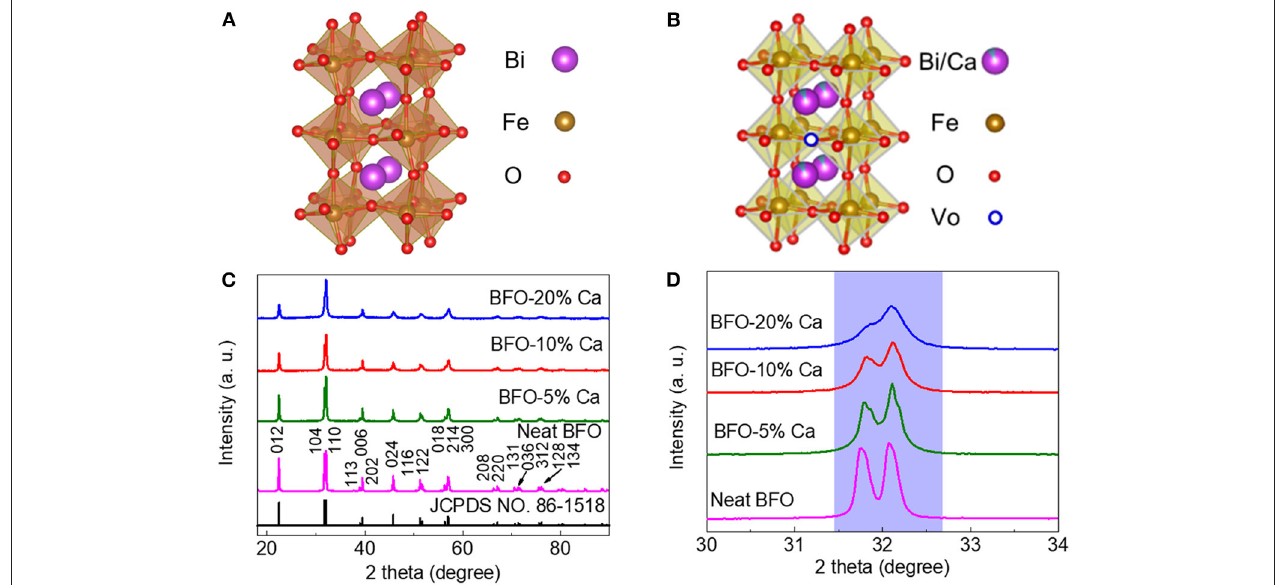
FIGURE 1 | (A,B) Schematic diagram of the crystal structure of BFO and BFO-Ca; (C) XRD pattern of different Ca 2 + ion doping; (D) Partial enlargement of the 2 theta ( ∼ 32 ◦ ) of BFO, BFO-5%Ca, BFO-10%Ca, and BFO-20%Ca.